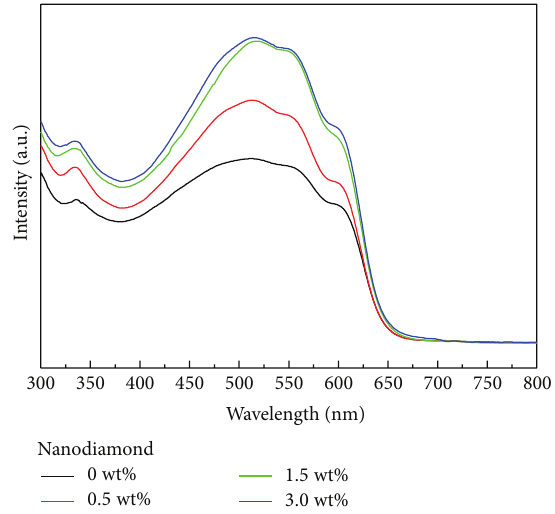
Figure 4: Absorption spectra of hybrid P3HT:PCBM film doped with nanodiamond at various concentrations.